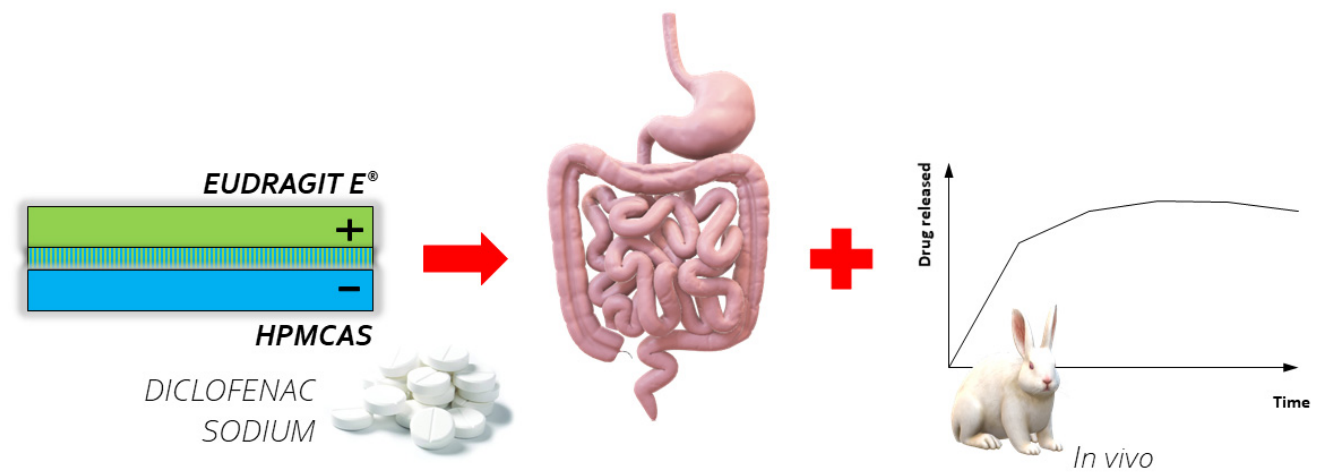
Figure 4. PEMs composed of cationic Eudragit E ® and anionic hypromellose acetate succinate (HPMCAS) as coatings for colon specific